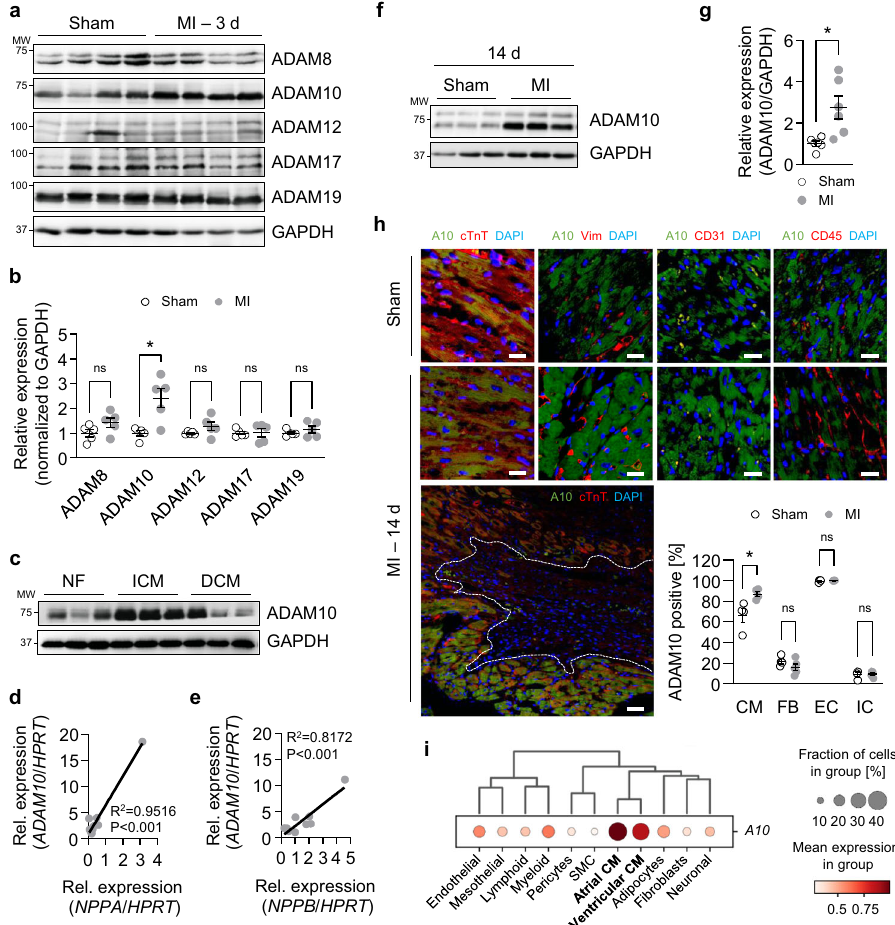
Fig. 1 | ADAM10is upregulated in experimental heart injury aswell as patients with ischemic cardiomyopathy and correlates with ANP/ BNP expression. a Western blot analysis and b quanti fi cation of indicated ADAMs in heart tissue lysates of sham-operated (Sham) and LAD-ligated (MI) mice 3 days after infarction ( n =5, mean±SEM, ns not signi fi cant, * P <0.05, two-tailed Mann – Whitney test). Exact P -values:ADAM8,0.150794.ADAM10,0.015873.ADAM12,0.150794.ADAM17, 0.690476. ADAM19, 0.690476. c Western blot analysis of ADAM10 in heart tissue lysates from patients with ischemic cardiomyopathy (ICM) and dilated cardio- myopathy (DCM) versus non-failing controls (NF) ( n =6). Pearson ’ s correlation of ADAM10 mRNA expression against expression of d NPPA (ANP) and e NPPB (BNP) ( n =12). Exact P -values: NPPA, <0.0001. NPPB, 0.0008. f Western blot analysis and g quanti fi cation of ADAM10 in heart tissue lysates of mice 14 days after sham-